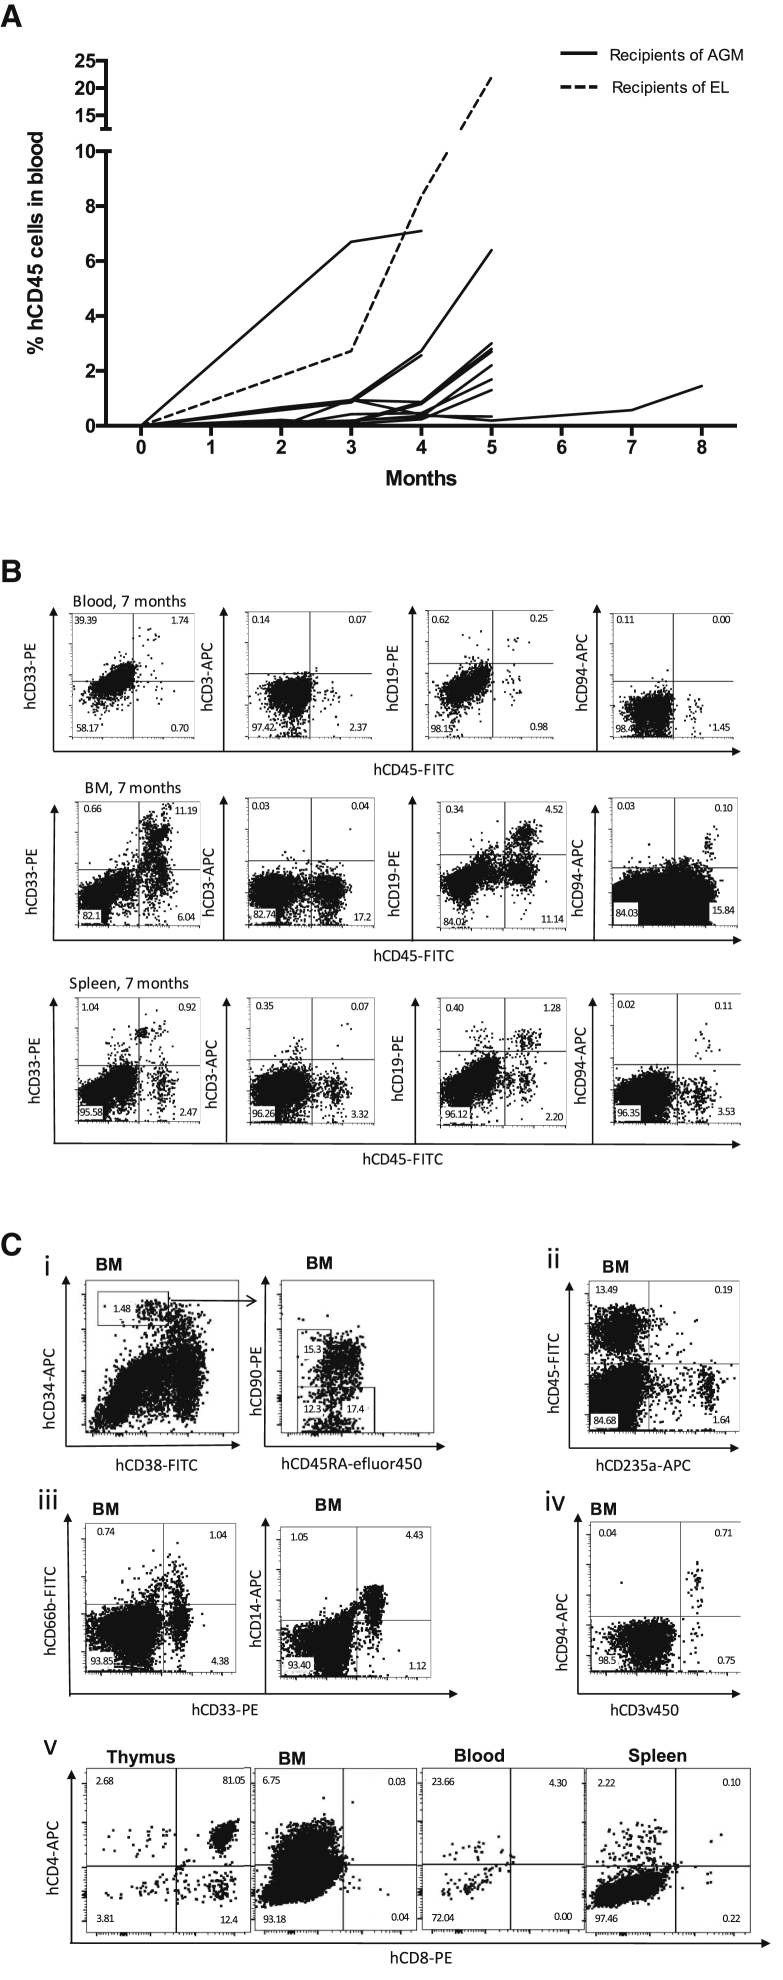
Explant Culture Maintains HSCs with Long-Term Multilineage Repopulating Capacity In Vivo(A) Kinetics of human hematopoietic repopulation in the peripheral blood for 14 NSG mice transplanted with cultured human AGM (solid lines) or embryonic liver (EL) (dotted line).(B) Representative flow cytometry plots of human myeloid (CD45+CD33+), T (CD45+CD3+), B (CD45+CD19+), NK (CD45+CD94+) cells in the peripheral blood, bone marrow, and spleen of an NSG mouse transplanted with 0.3 ee of a cultured CS16 human AGM region (part 2), culled for analysis at 7 months.(C) Representative flow cytometry plots of HSCs (CD34+CD38−CD90+CD45RA−), multipotent progenitors (MPPs) (CD34+CD38−CD90−CD45RA−), and multi-lymphoid progenitors (MLPs) (CD34+CD38−CD90−CD45RA+) (i), erythroid cells (ii), myeloid cells (iii), NK/NKT cells (iv), and T cells (v) in the bone marrow, blood, spleen, and thymus of NSG mice. (i), (ii), and (v) are from a primary recipient mouse injected with 0.96 ee of AGM part 3 from a CS16 embryo cultured for 7 days, culled for analysis at 4 months. (iii) and (iv) are taken from a primary recipient mouse injected with 0.28 ee AGM posterior half, from a CS17 embryo cultured for 7 days, culled for analysis at 5 months.All plots are gated on 7AAD singlets. Flow cytometry controls are shown in Figure S4. BM, bone marrow.